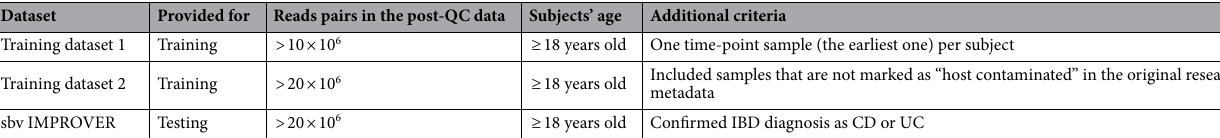
Table 5. Criteria used for sample